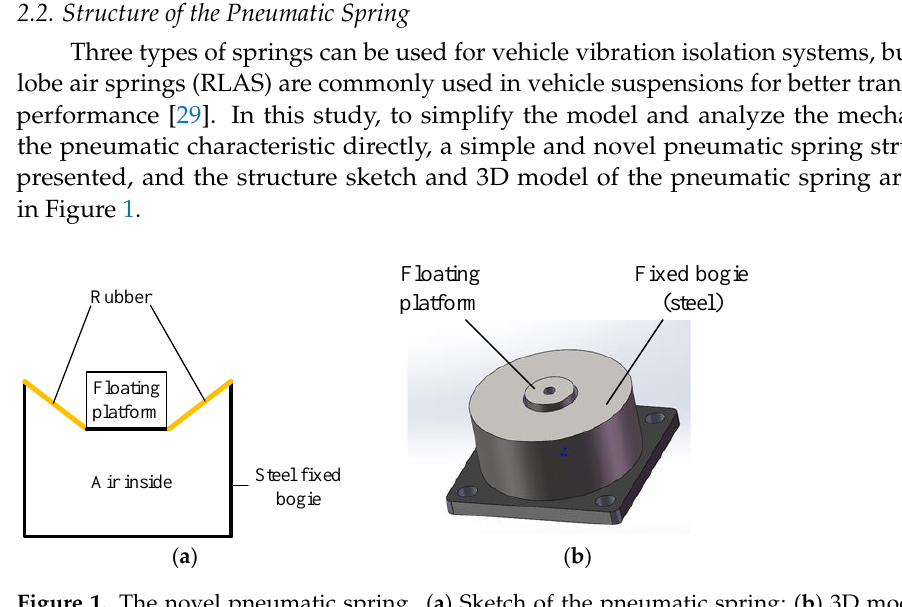
Figure 1. The novel pneumatic spring. ( a ) Sketch of the pneumatic spring; ( b ) 3D model of the pneumatic spring.